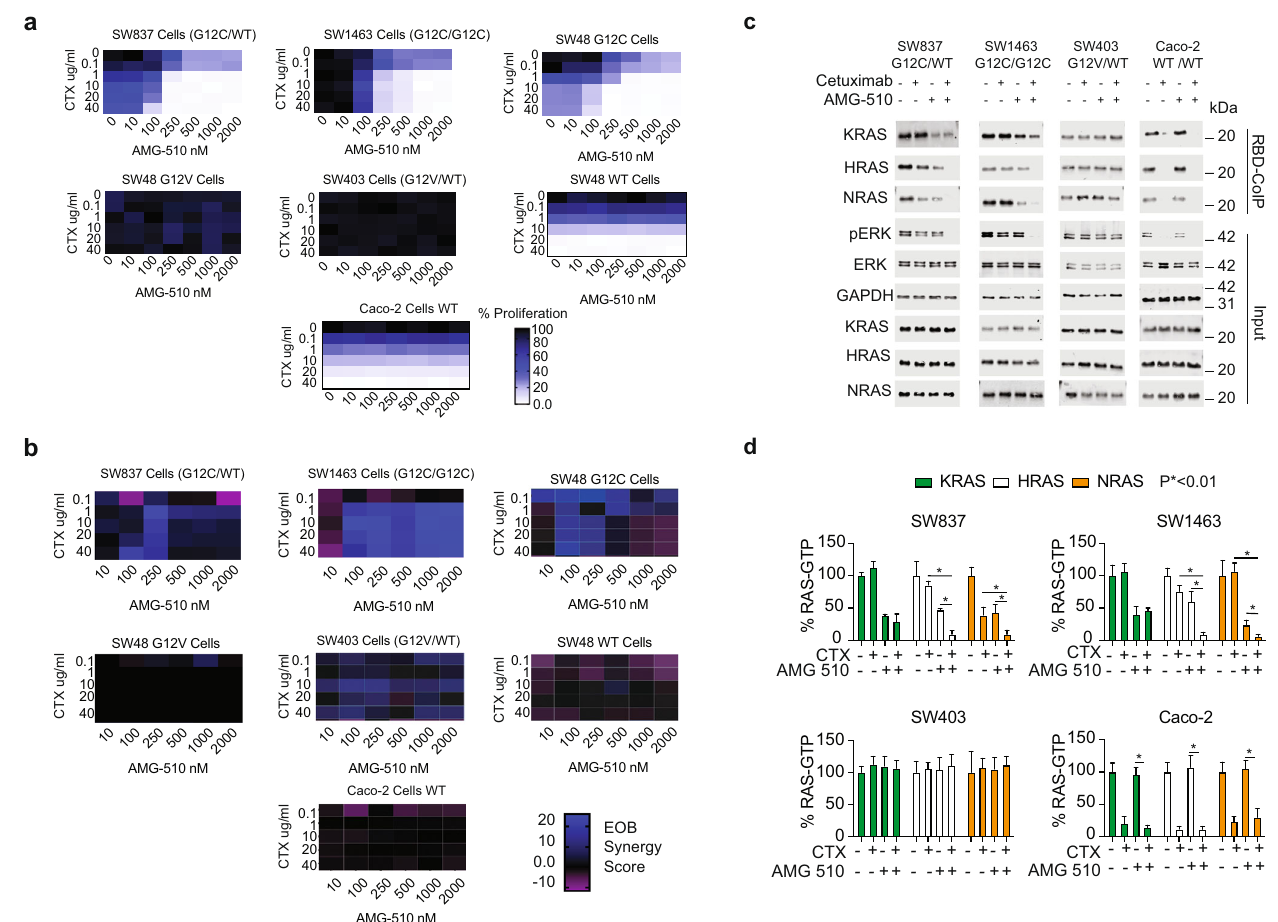
Fig. 1 The combination of AMG-510 and cetuximab results in suppression of wild-type RAS-GTP. a Cellular proliferation as measured by the MTT assay for SW48 G12C (KRAS G12C/WT ), SW48 KRAS G12V (KRAS G12V/WT ), SW48 (KRAS WT/WT ), SW1463 (KRAS G12C/G12C ), SW837 (KRAS G12C/ WT ) Caco-2 (KRAS WT/WT ), and SW403 (KRAS G12V/WT ) treated with combinations of cetuximab and AMG-510 for 48 h. Heatmaps present average values from three separate experiments. b Calculated Excess over Bliss (EOB) synergy scores for the data in a . c Active RAS measurements by RBD-WB for SW837, SW1463, SW403, and Caco-2 cells treated either with vehicle, 1 μ g/ml cetuximab, 250 nM AMG-510 or both 1 μ g/ml cetuximab and 250 nM AMG-510 for 48 h. Results are representative of three separate experiments. d Mean RAS-GTP levels from three RBD- WB RBD pulldown assays with standard deviation. IP and western blot experiments were performed three times, bar plots represent mean abundance and error bars represent standard deviation. Statistical signi fi cance was determined by performing one-way ANOVA followed by post-hoc Tukey ’ s test for multiple comparisons. P -values are indicated within each panel comparing combination treatment to cetuximab and AMG-510